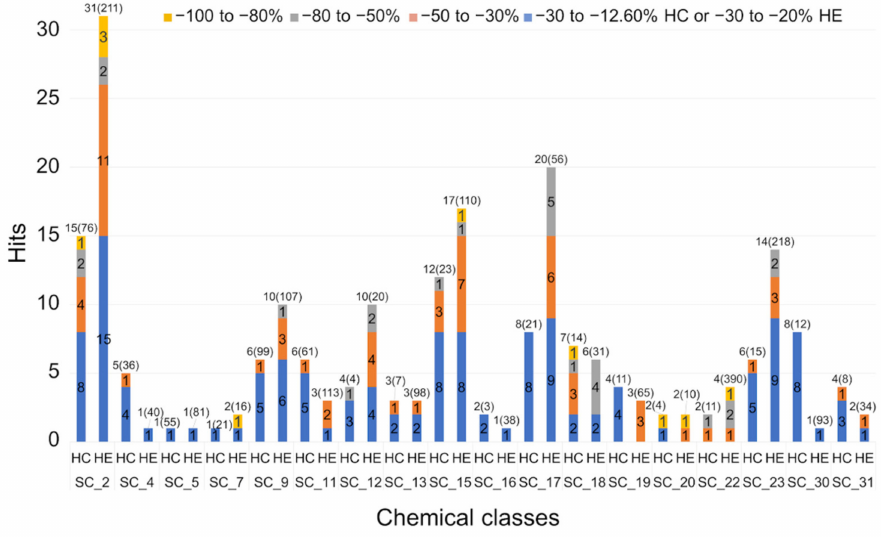
Figure 9. Stacked bar chart showing the hit distribution per scaffold within i–iv ranges of activity percent: (i) − 100% to − 80%, (ii) − 80% to − 50%, (iii) − 50% to − 30%, (iv) − 30% to − 12.60% (HC) or − 30% to − 20% (HE), as obtained from the HC and HE stages. Each range was considered as half-closed interval of activity percent in which the largest endpoint was included. On the top of the bars, the total hits and the total tested compounds in brackets are reported. For the sake of simplicity, scaffolds without active representatives in the HE are not reported in the